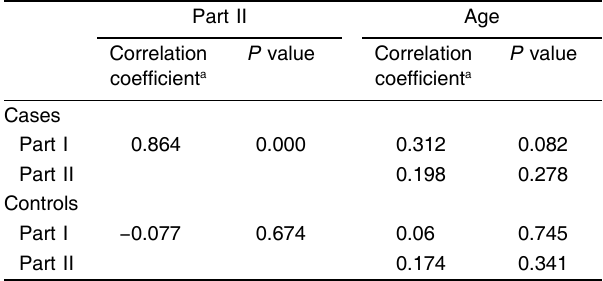
Table 4 Correlation between part I and part II assessment scores and age